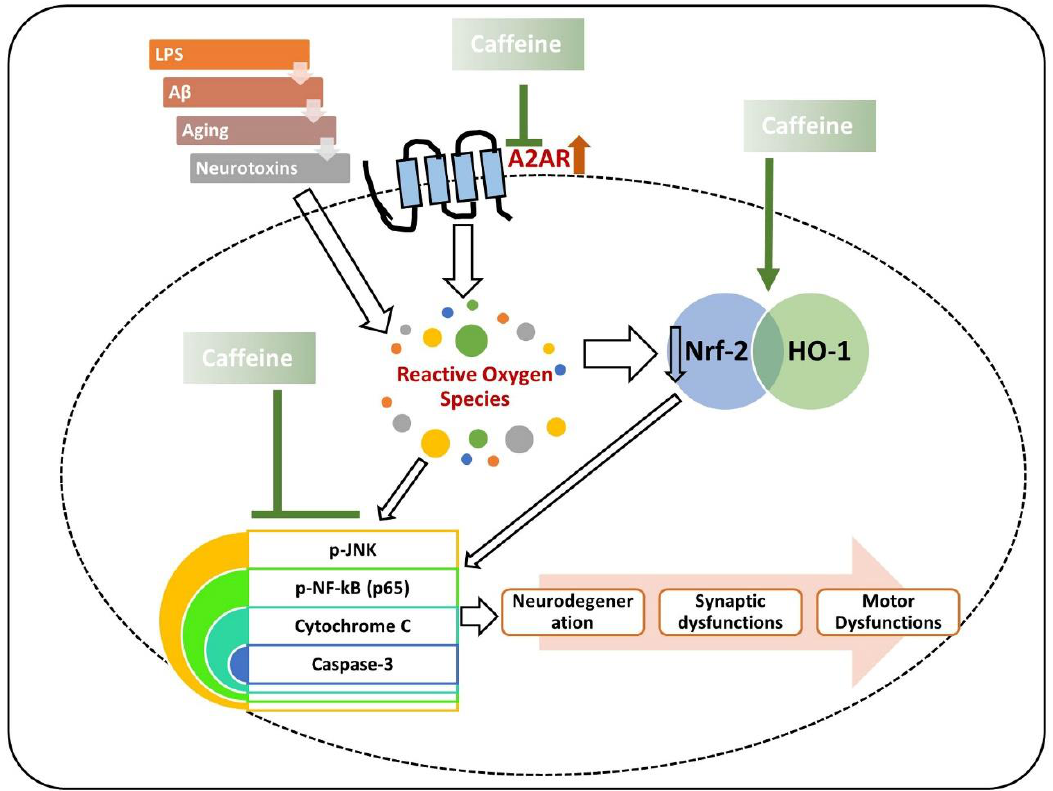
Figure 3. Role of ca ff eine in the management of neurodegeneration. The rescuing e ff ects of ca ff eine against neurotoxins and age-related neurodegeneration. Ca ff eine suppresses the expression of the A2A receptor and upregulates the expression of nuclear factor erythroid 2-related factor 2 (Nrf-2), thereby regulating the inflammatory mediators (phospho-c-Jun n-terminal kinase (p-JNK), phospho-nuclear factor-kappa B (p-NF-kB)), apoptotic markers (cytochrome C, and caspase-3), synaptic dysfunctions, and neurodegeneration. Green arrows are used for the beneficial e ff ects of ca ff eine. The arrows with white background are showing the inducing e ff